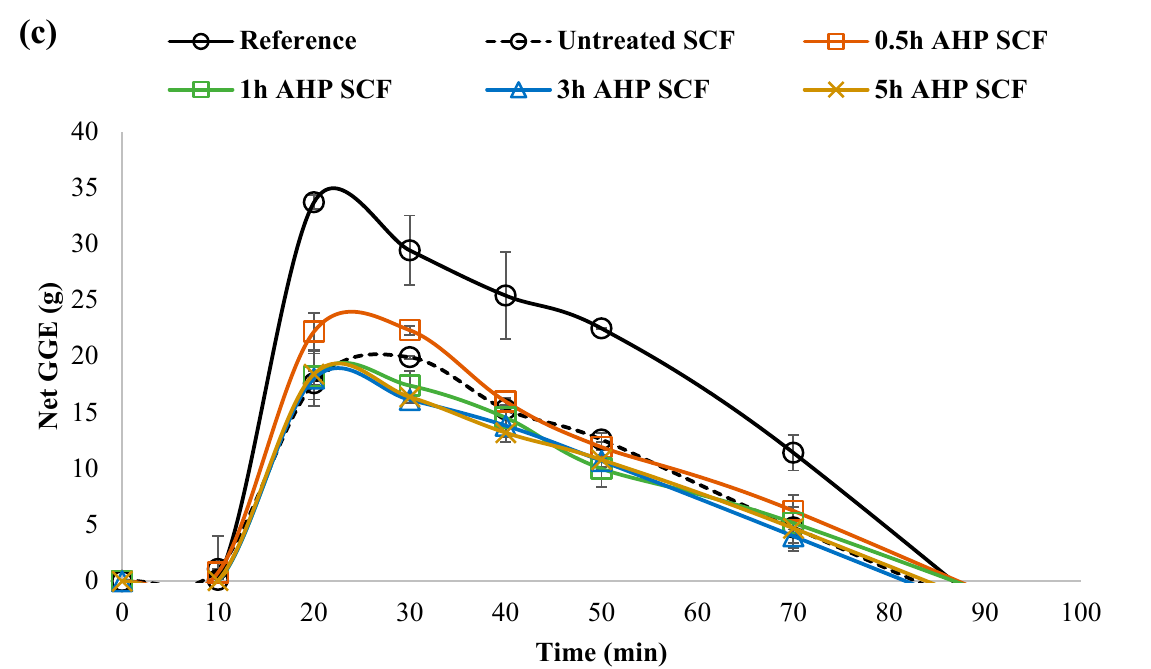
Figure 5. ( a ) GGE release curves illustrating overall glucose release. ( b ) GGE disposal curves. ( c ) Net GGE curves. Error bars represent mean ± standard deviation ( n = 2). All data were calculated based on the fresh weight of the bread samples without SCF incorporated (reference), incorporated with 5% untreated SCF, and 0.5 to 5 h AHP SCF.